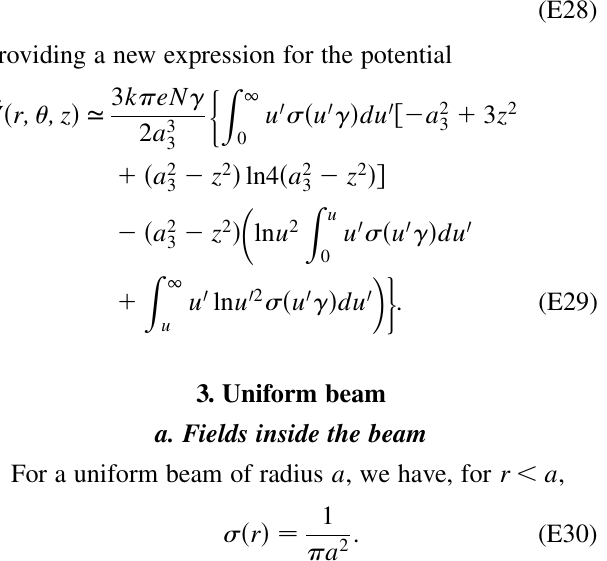
The transverse electric field is